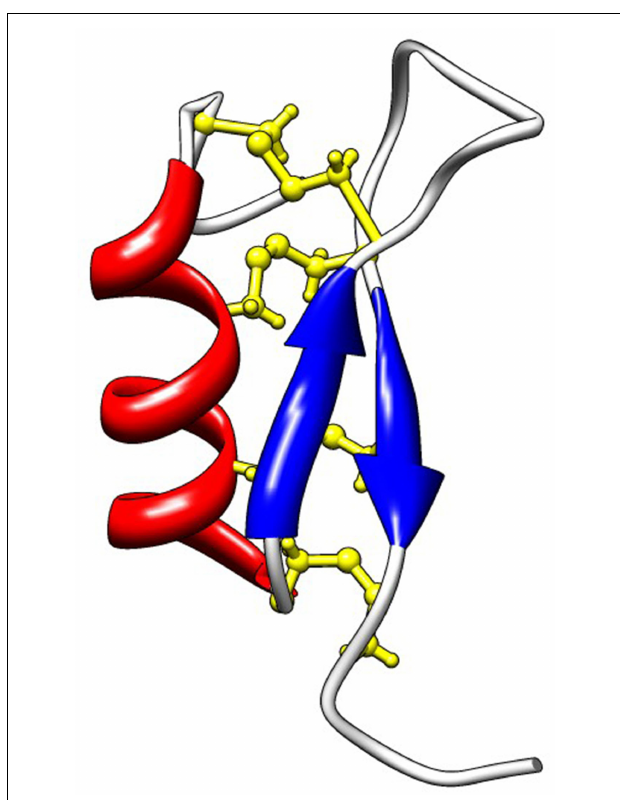
FIGURE 3 | Solution structure of Cg -Defm (PDB: 2B68). Cg- Defs display the CS αβ motif also found in defensins from plants, fungi, and invertebrates, which is composed of an α -helix (red) linked to an antiparallel two-stranded β -sheet (blue) by disulfide bridges (yellow). In Cg -Defs, eight cysteines are involved in four disulfide bridges as follows: C 1–5 C 2–6 C 3–7 C 4–8 .